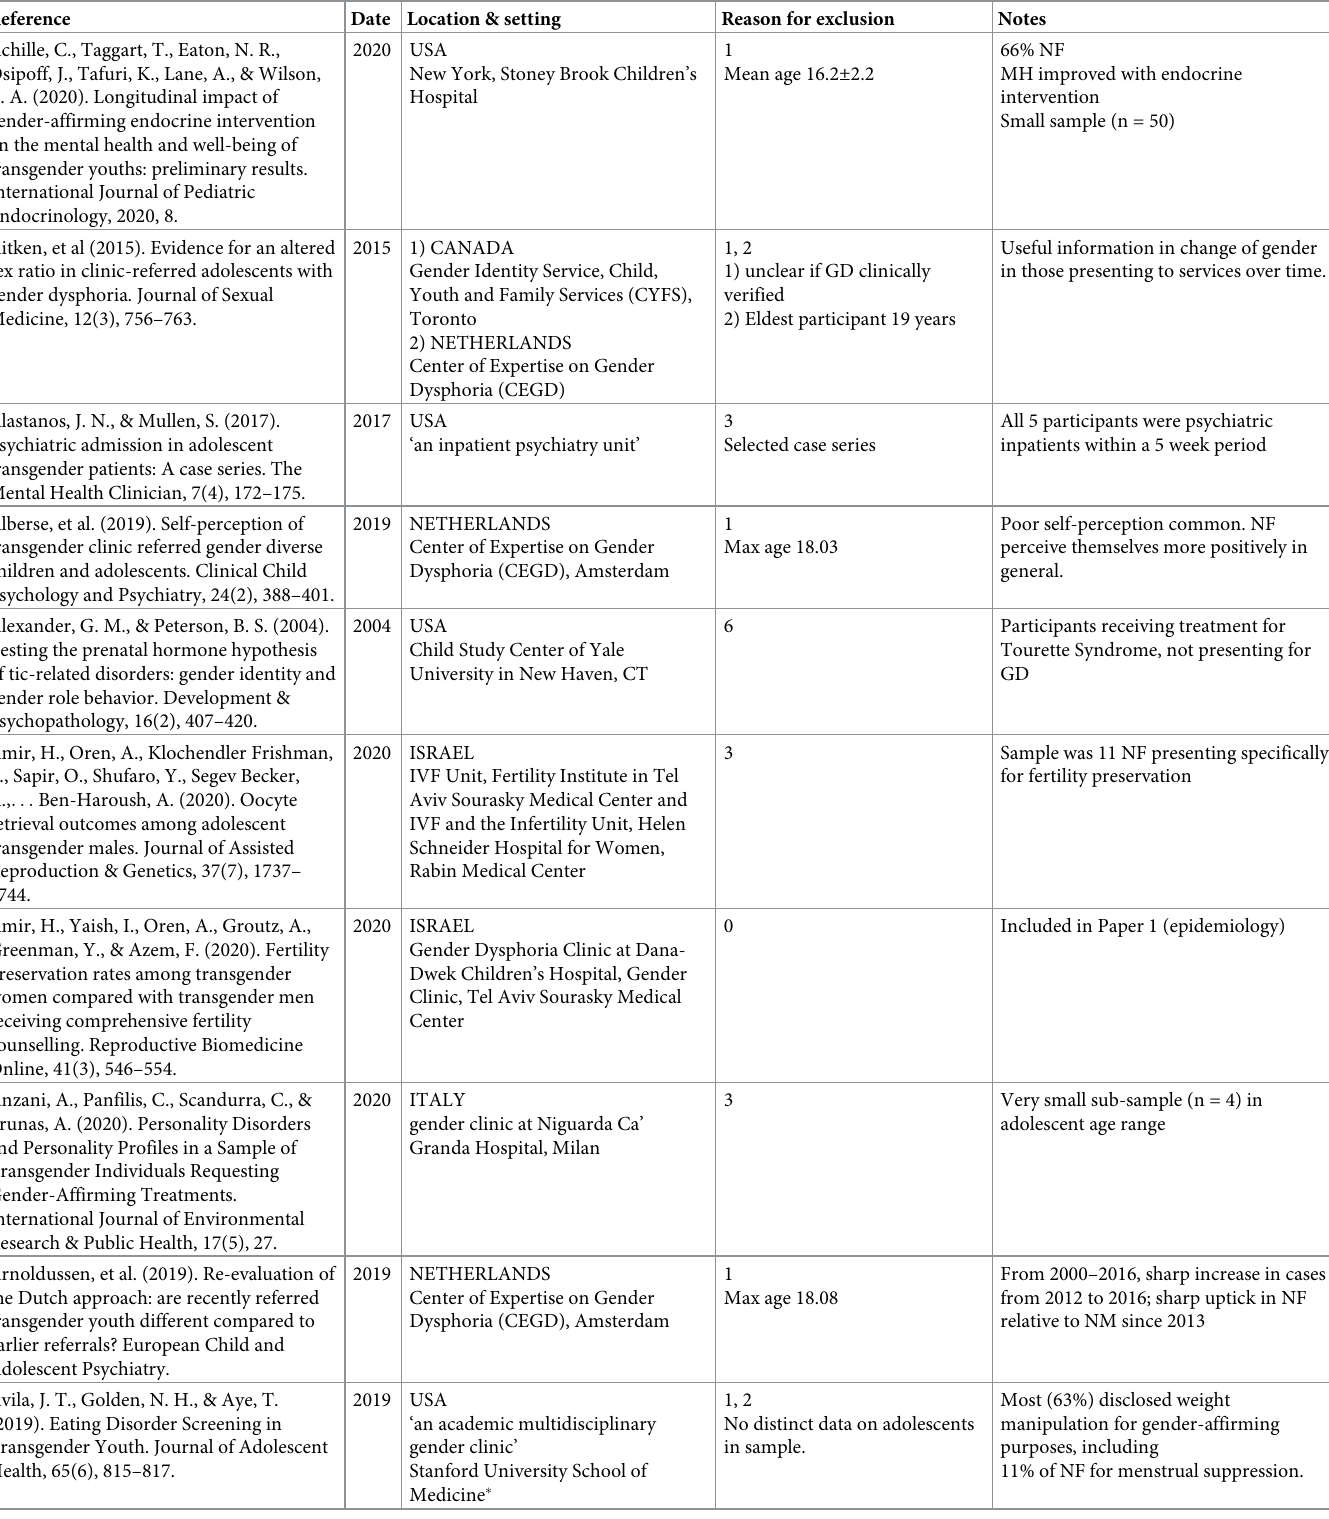
Table 5. Papers excluded at second full text screen (i.e., closely missed meeting inclusion